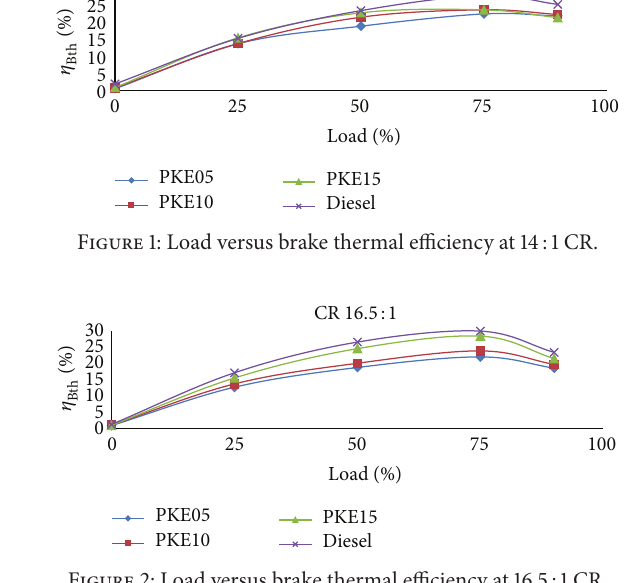
Figure 2: Load versus brake thermal efficiency at 16.5: 1